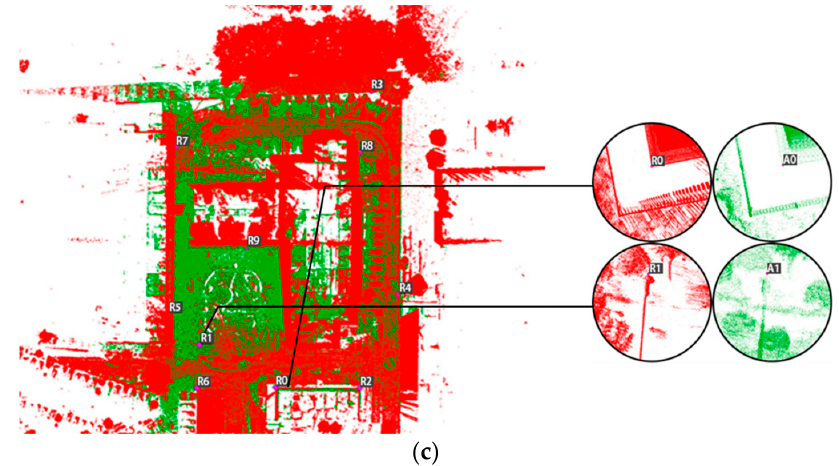
Figure 15. The distribution of corresponding point pairs in each dataset. The color of the terrestrial laser scanning (TLS) point is red, and the color of the SLAM point is green in the figure. ( a ) Dataset 1; ( b ) dataset 2; ( c ) dataset 3.